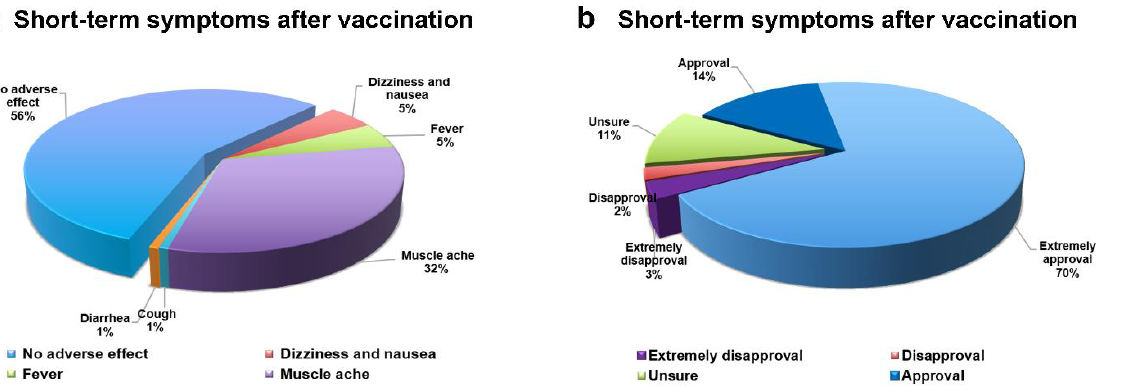
Figure 2. Percentage of individual symptoms and vaccination trust rank survey. ( a ) Reference = 34.94%: 34.94% of survey participants had been vaccinated with booster shots; all percentages are for vaccinated booster participants. ( b ) The pie chart represents a vaccination scale for the 395 questionnaire respondents divided into 5 sections.